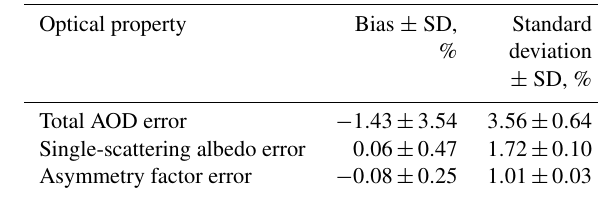
Table 2. Statistics of aerosol property error analysis from 20 ML models (20 different training